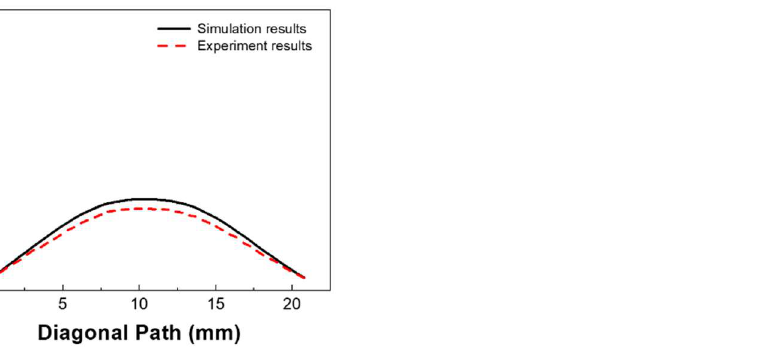
Figure 13. Comparison of the warpage of the flexible packaging between the experimental results and the simulation results.